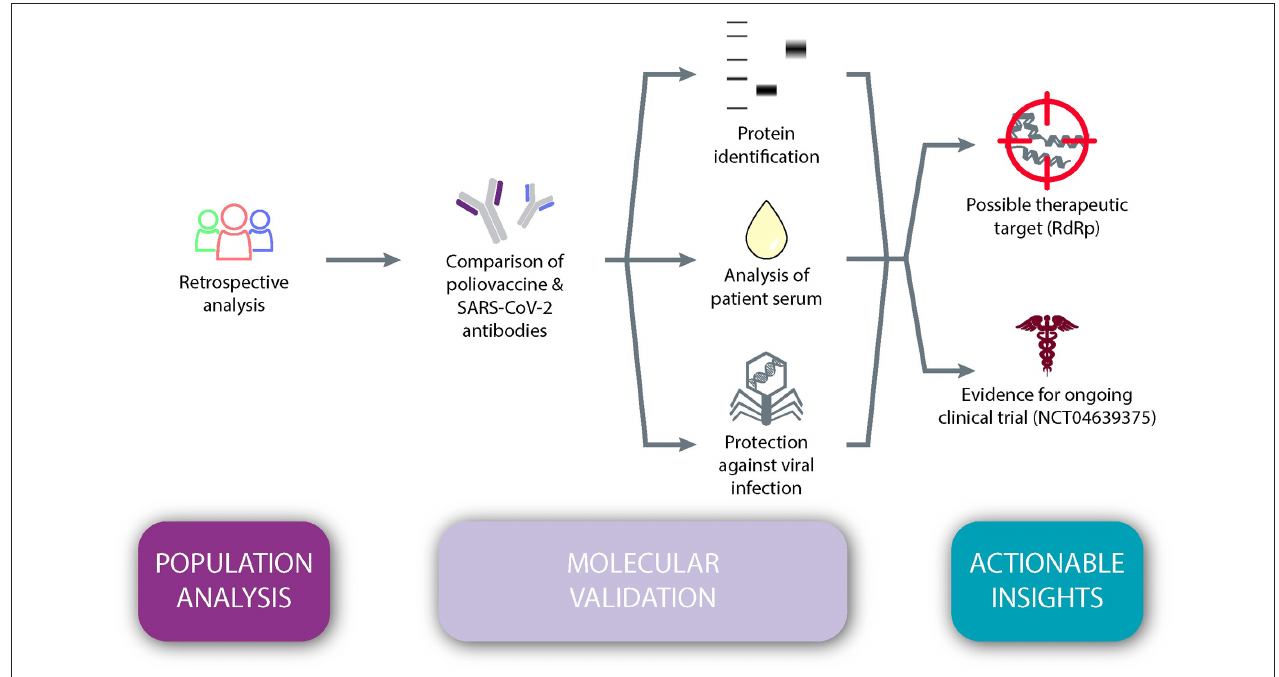
FIGURE 1 | An observational study design testing the hypothesis that immunity against SARS-CoV-2 is dependent upon one’s age and that poliovirus vaccination plays a vital role in this apparent